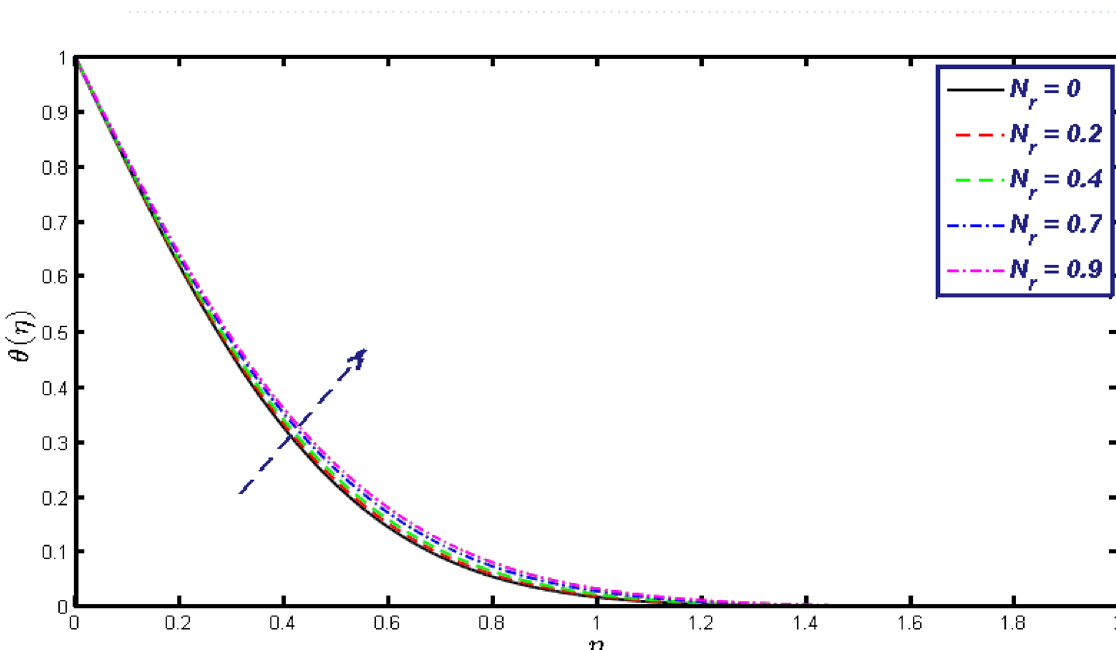
Figure 12. θ(η) field for different values of Nr